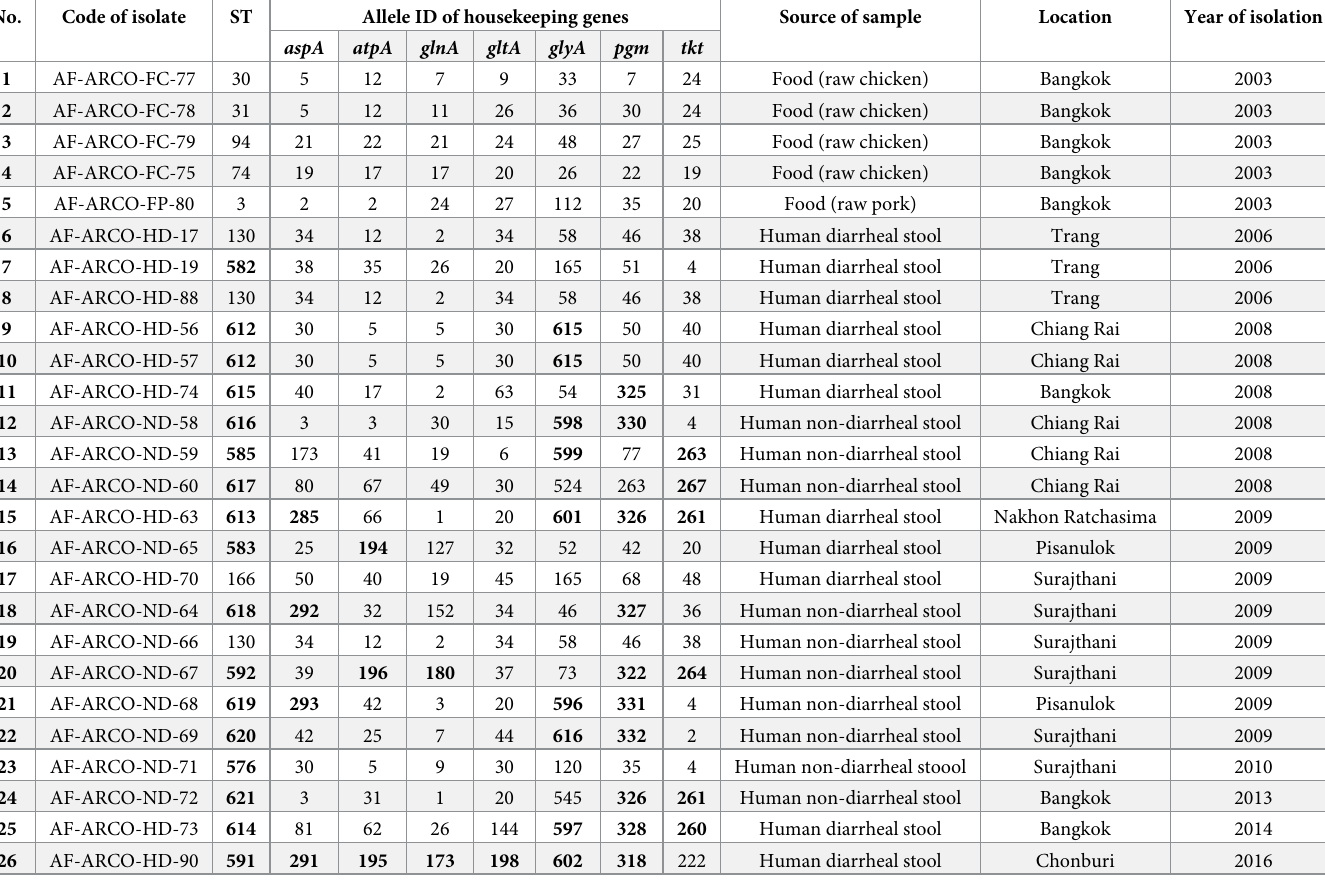
Table 4. Multilocus sequence typing results of the 26 Arcobacter butzleri isolated from human diarrheal and non-diarrheal stool and food